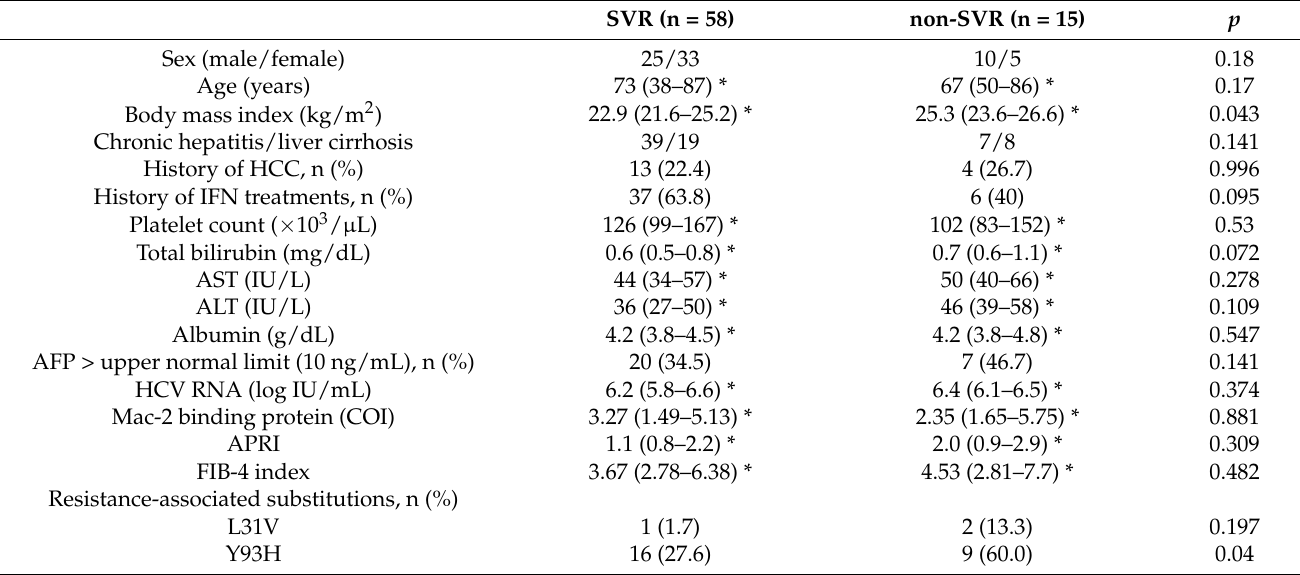
Table 1. Baseline characteristics of study patients (n =